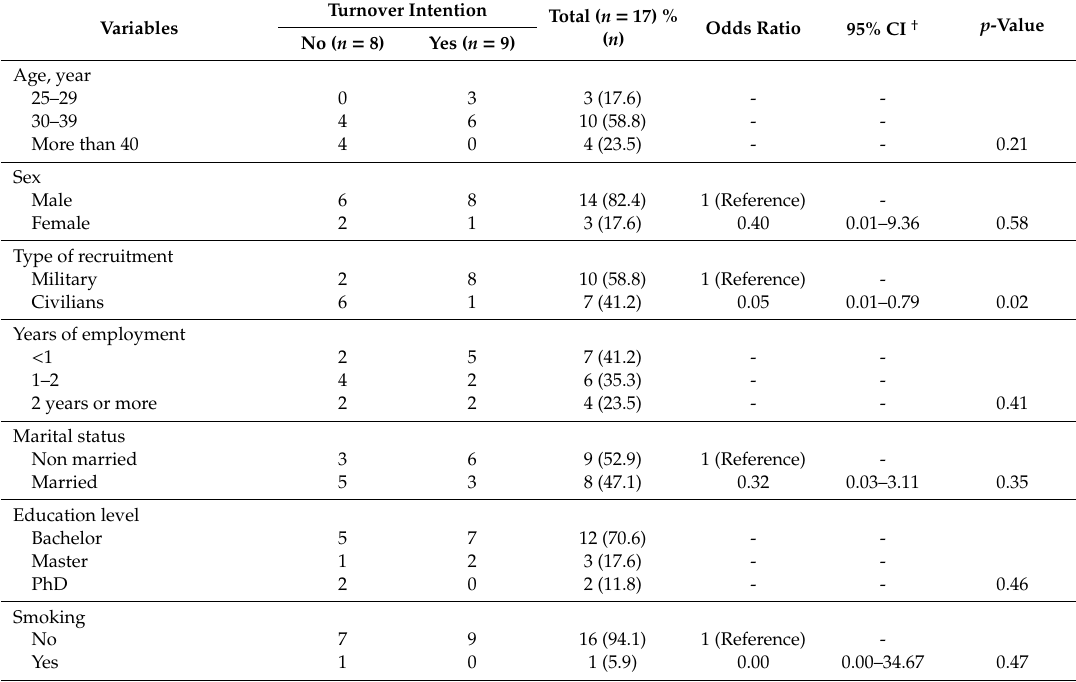
Table 1. Demographics of the study population and association with turnover